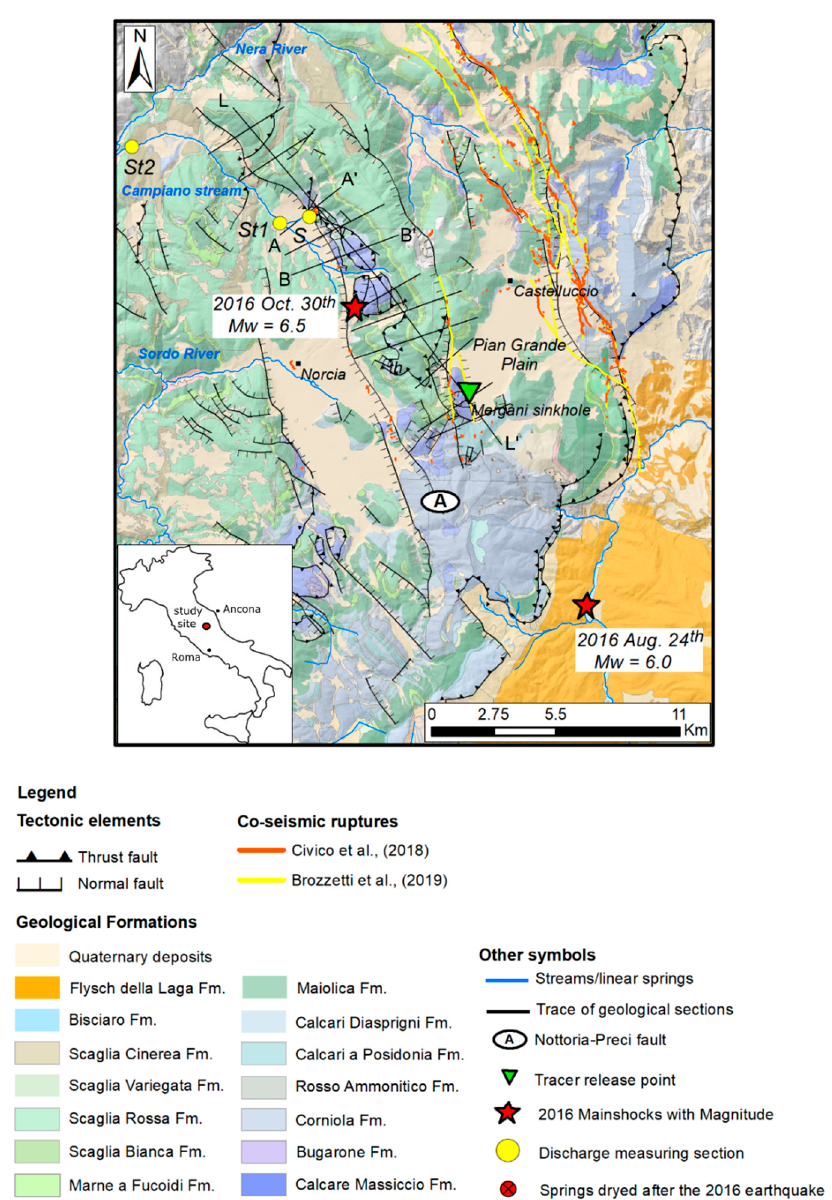
Figure 1. Geological sketch of the area with indication of sections monitored for discharge measure- ments, co-seismic ruptures and mainshocks of the 2016 earthquakes. Geological cross-section traces are indicated.